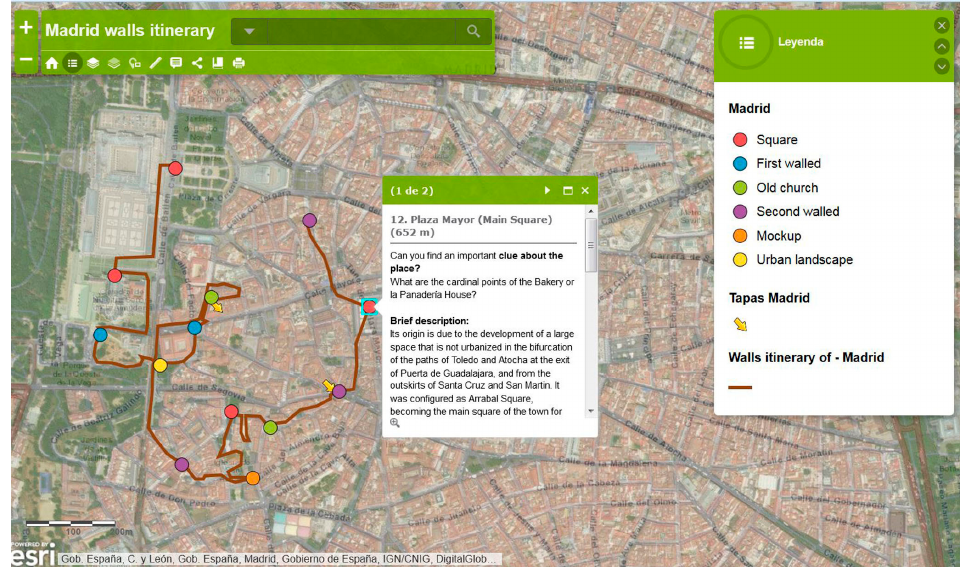
Figure 2. WebGIS about Madrid origin, historical center and heritage using an itinerary around the old walls (Madrid, Spain).